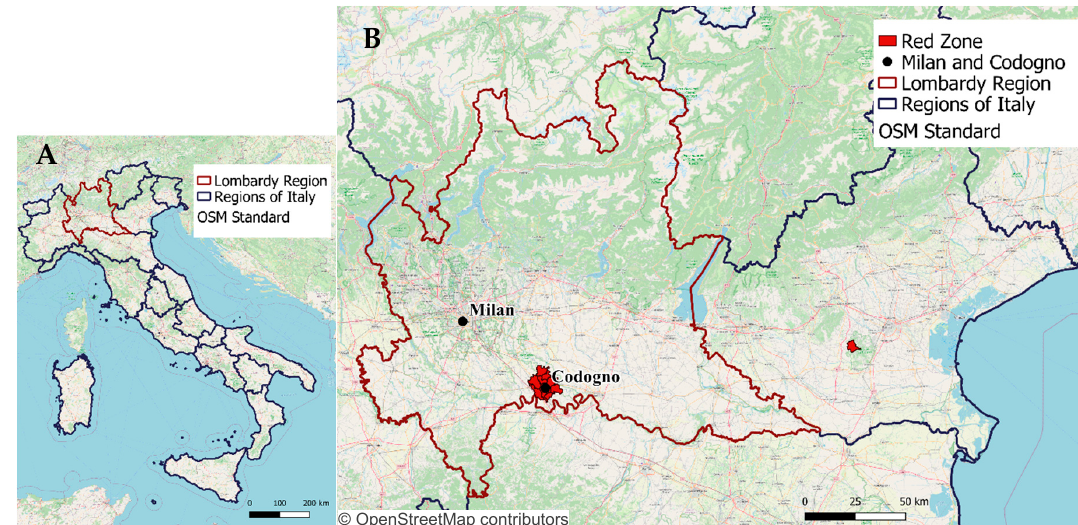
Figure 1. Map of Italy divided into administrative regions ( A ), with Lombardy region highlighted (red). In the right panel ( B ), the positions of the 12 municipalities in complete lock-down as a “red zone” on 24 February 2020, located both in Lombardy and Veneto regions, are highlighted, together with the location of the city of Milan (capital of Lombardy) and Codogno (the town where the first Italian patient was diagnosed with COVID-19 on 21 February 2020).